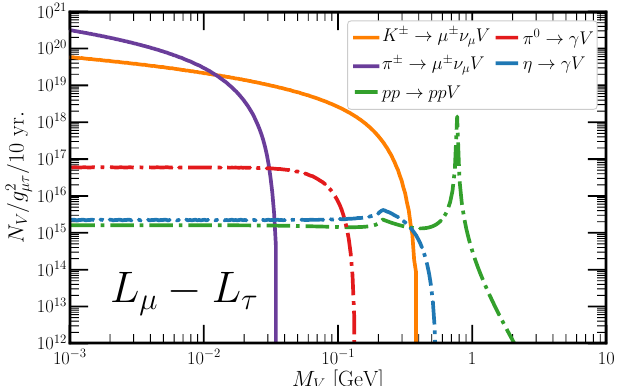
Figure 11 . The number of L (cid:22) L (cid:28) gauge bosons V traveling towards the DUNE MPD as a (cid:0) function of mass M V assuming ten years of data collection, and equal run time in neutrino and antineutrino modes. Solid lines display expected number due to charged meson decays | purple ( (cid:25) (cid:6) ) and orange ( K (cid:6) ). Dot-dashed lines display expected number due to processes relying on kinetic mixing | red ( (cid:25) 0 decay), blue ( (cid:17) decay), and green ( pp ppV bremsstrahlung). ! mixing. This width is given by eq. (5.5) with the replacement g (cid:11)(cid:12) e" (cid:11)(cid:12) . The !